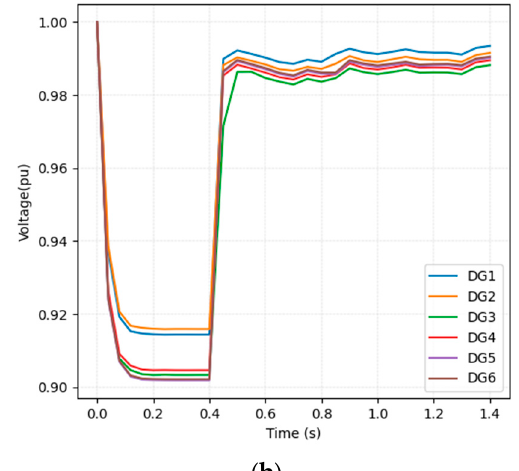
Table 2. Performance trained MARL policies under different load